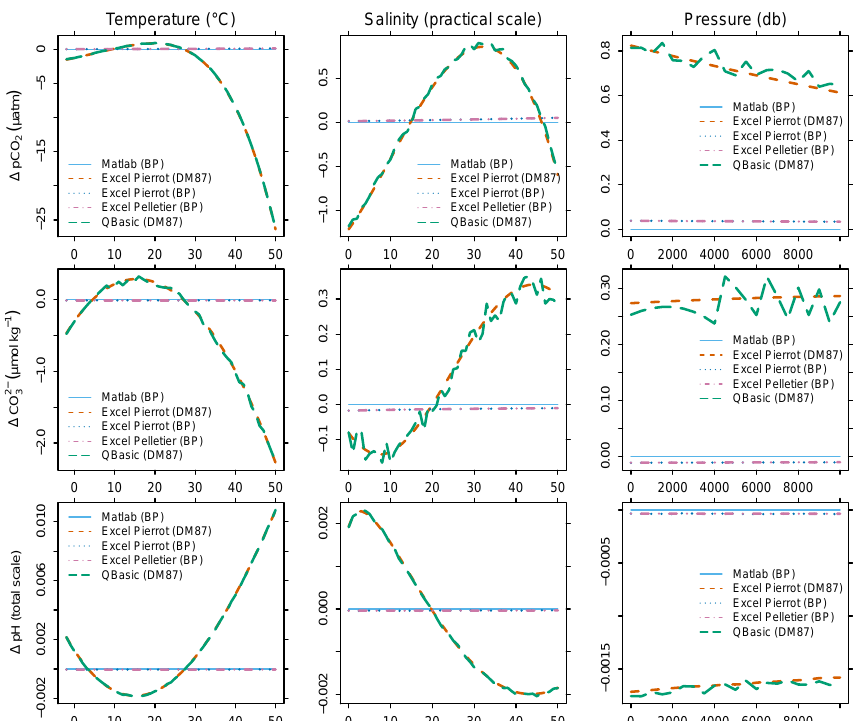
Figure 1. Differences ( (cid:49) ) between the variants of CO2SYS relative to the reference MATLAB code for variables computed from A T and C T . Differences are shown across ranges of T (left), S (center), and P (right) for p CO 2 (top), CO 2 − most recent variants (MATLAB and both Excel versions) are run with constants recommended for best practices (BP). The QBasic variant does not offer the same K 1 and K 2 , so we used an earlier refit by Dickson and Millero (1987) of the same data (DM87) and compared it to one Excel version also with